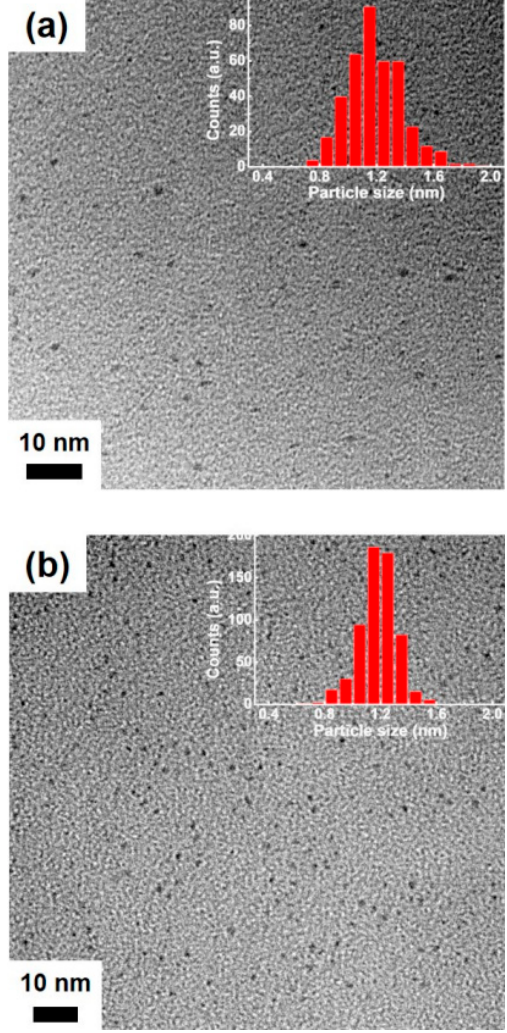
Figure 4. TEM images of ( a ) as-synthesized Au NCs and ( b ) dopamine-conjugated Au NCs. The insets of ( a ) and ( b ) show size distribution histograms of the NCs.